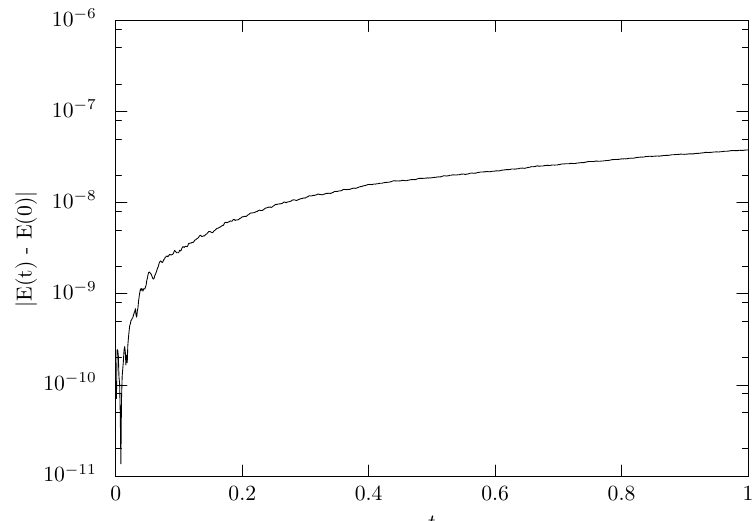
Figure 10. The deviation of the total energy in Equation (99) from the initial state. The energy is conserved up to the rounding